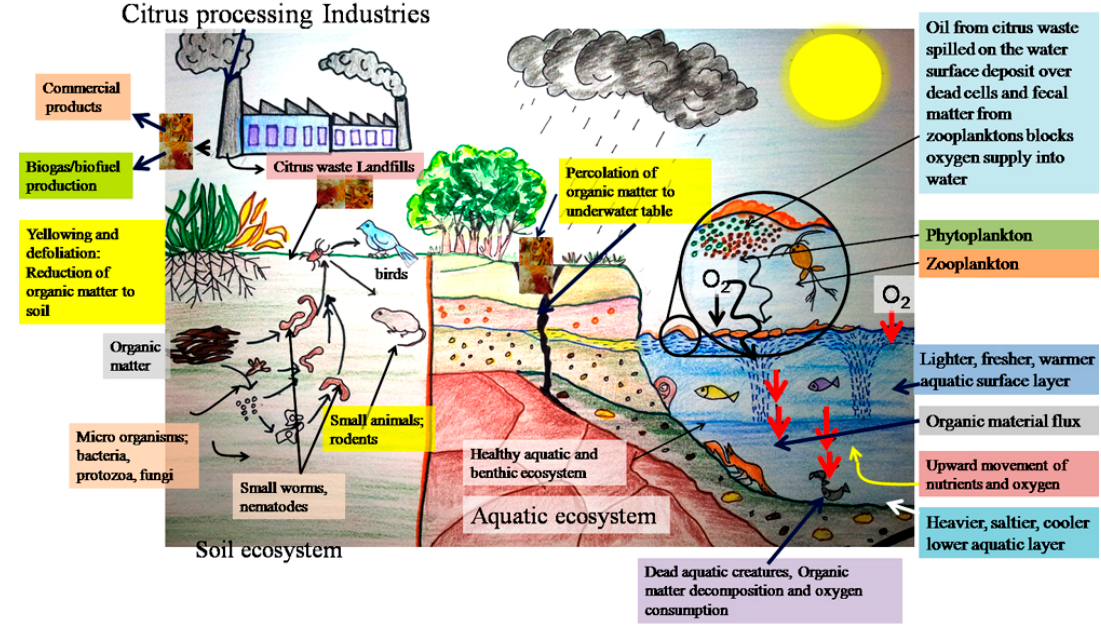
Figure 4. Schematic diagram illustrating the risks and potential threat of damage to soil and aquatic ecosystems and the overall environment by the disposal of untreated citrus wastes.